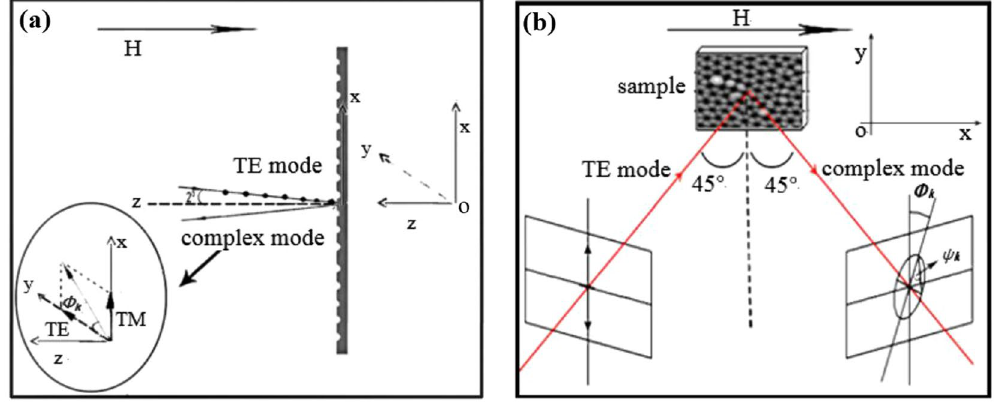
Figure 5. ( a ) P-MOKE and ( b ) L-MOKE measurement